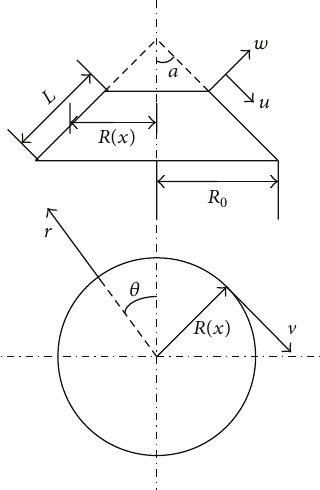
Figure 1: Geometry of a conical shell and the coordinate